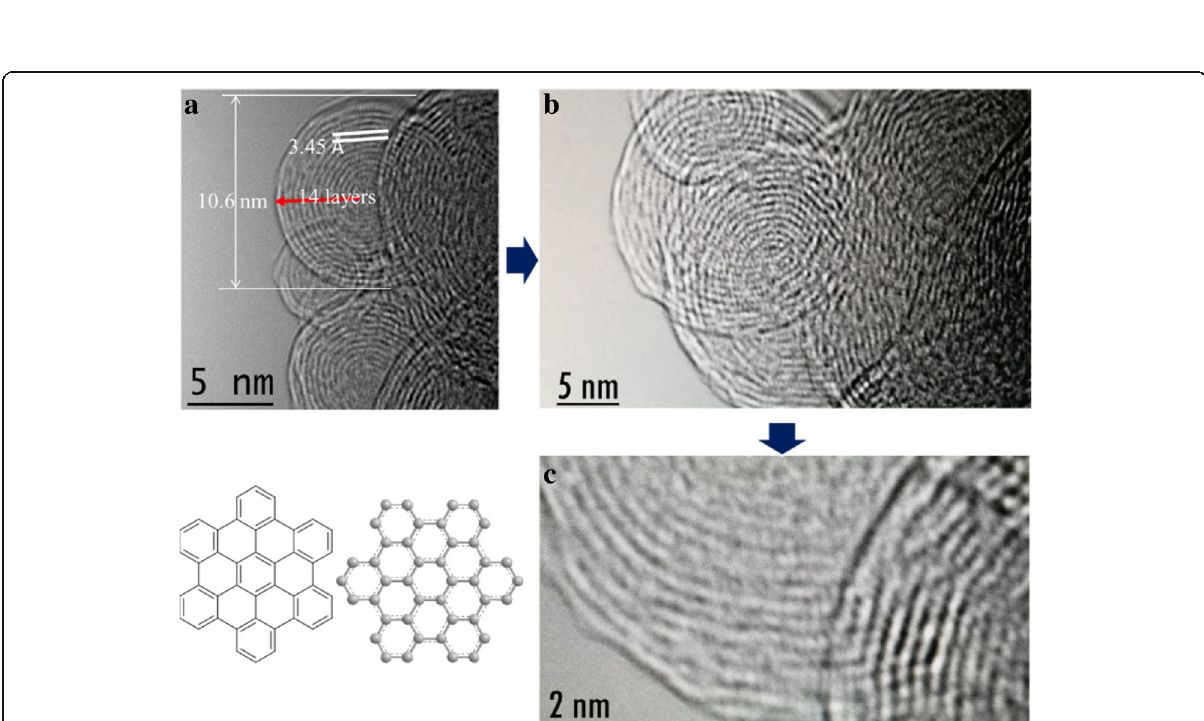
Fig. 4 HRTEM image of hexabenzocoronene with their dynamic hierarchical